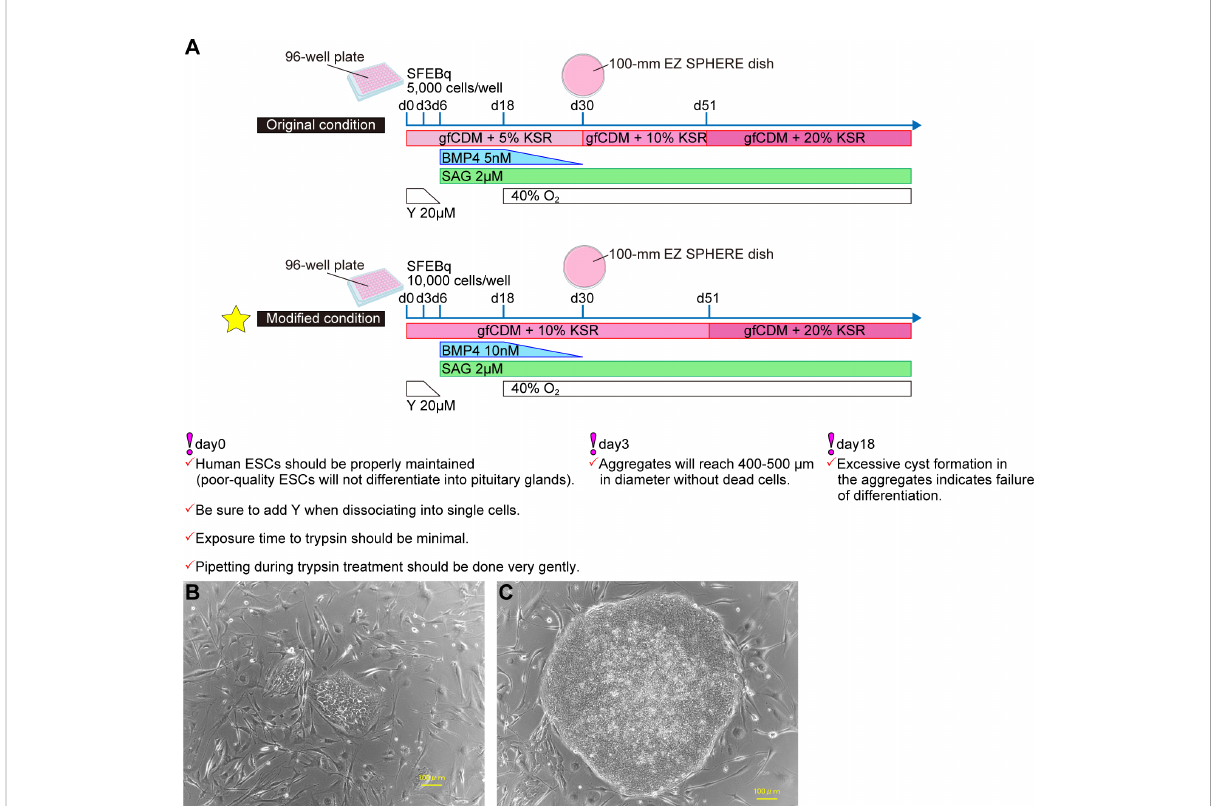
FIGURE 2 Ef fi cient pituitary differentiation from hPSCs. (A) Pituitary differentiation from hPSCs and critical points for succesful induction. Above, original conditions (7). Below, modi fi ed conditions (8). This article describes the modi fi ed method. (B) Human PSCs one day after passage. (C) Human PSCs three days after passage. Healthy hPSCs have well-de fi ned colony edges and high cell density in the colony center. Suitable colony diameter for passage is 1mm – 2mm. Scale bars: 100 µm (B, C)